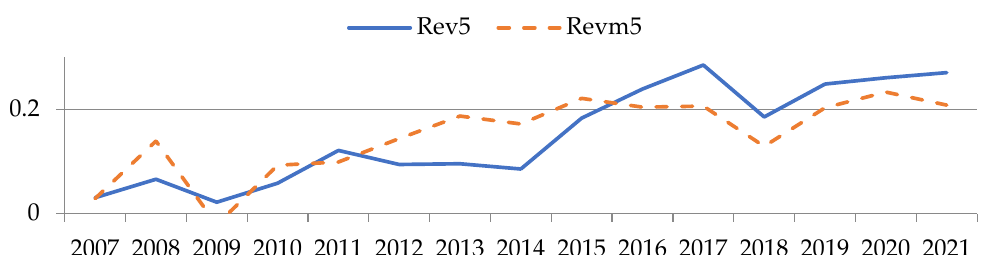
Figure 5. Comparison between real revenue and model value calculated by Formula (1) for industry No. 5, (author’s results).